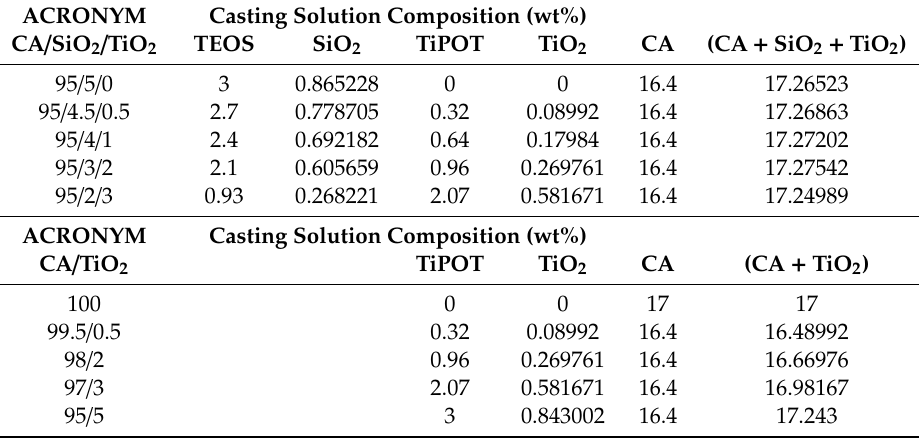
Table A1. Membrane Acronyms and Casting Solution Composition (series 1 and series 2).